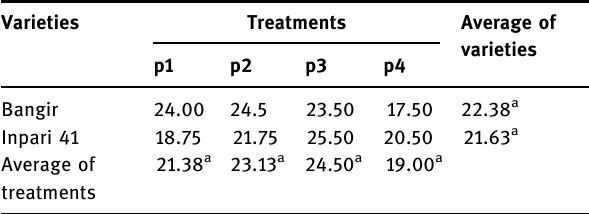
Table 4: Number of tillers of two rice varieties fertilized